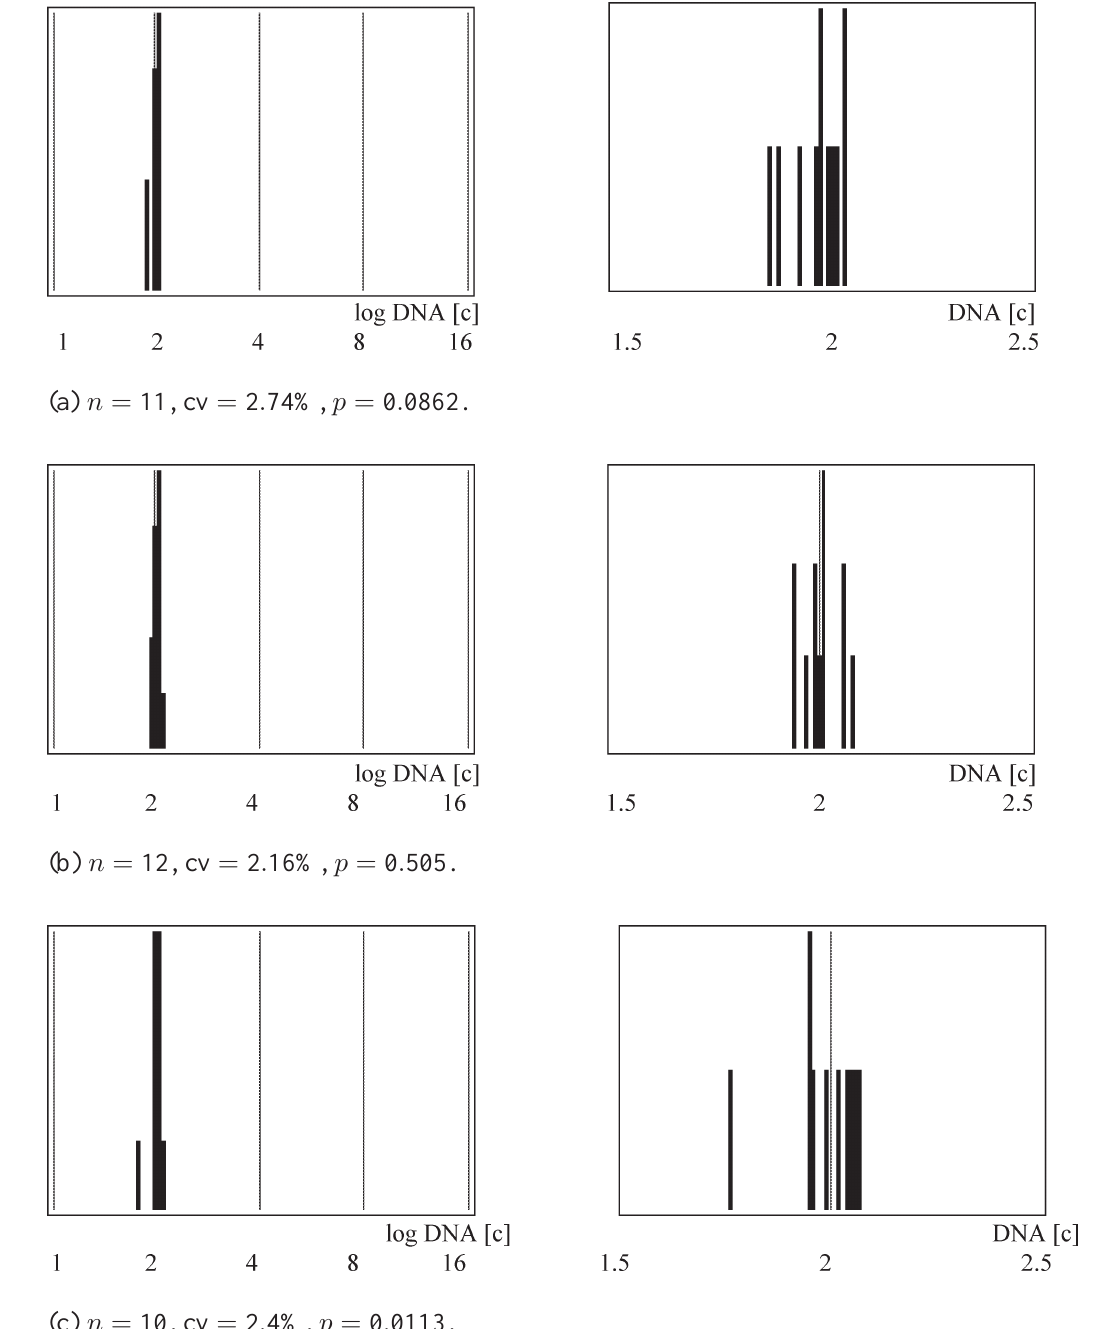
Fig. 1. DNA histograms of internal reference cell populations from 4 different breast cancer imprints. Each histogram is shown twice with different scaling. n . . . number of reference cells; cv . . . coefficient of variation (non-parametric estimation from the quantils) of the IOD values; p.. . error probability resulting from the W -statistics. A DNA peak is regarded not to be normally distributed, if p 6 0 .